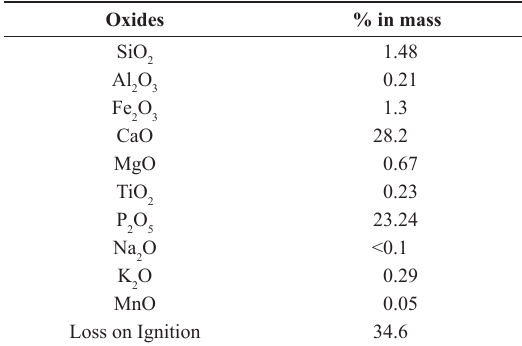
Table 1. Chemical analysis for the SSP